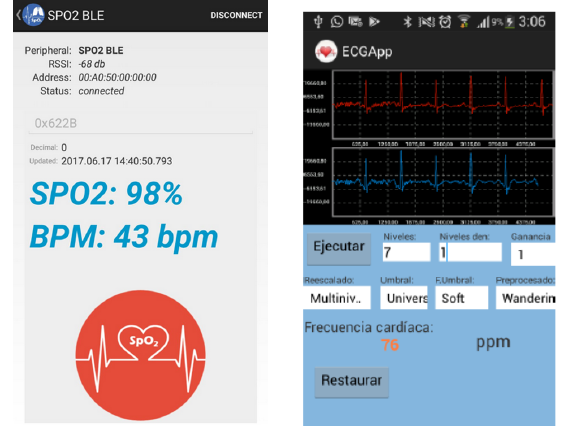
Figure 9. Android app